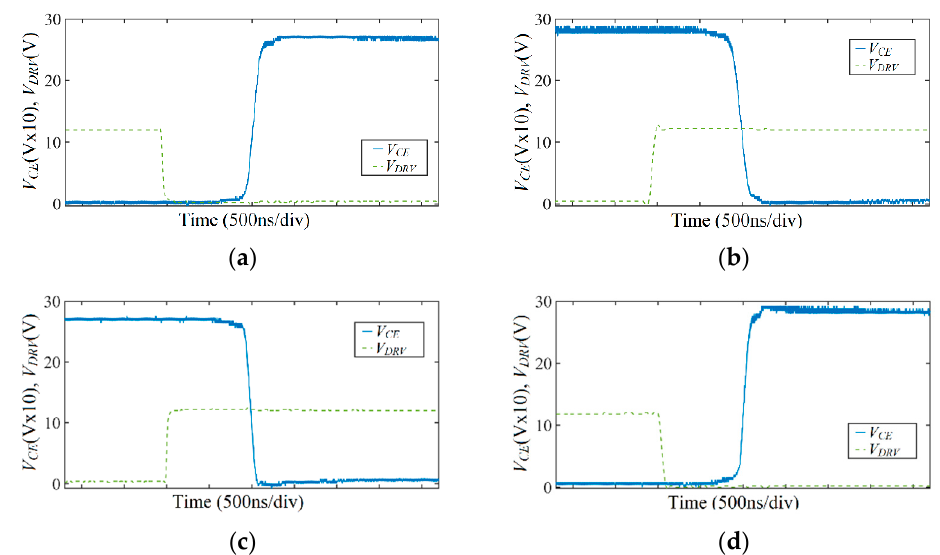
Figure 8. Cross-conduction waveforms: ( a ) The high-side turn-off time equals 972 ns; ( b ) The low-side turn-on time equals 984 ns; ( c ) The high side turn-on time equals 1036 ns; ( d ) The low-side turn-off time equals 1078 ns.